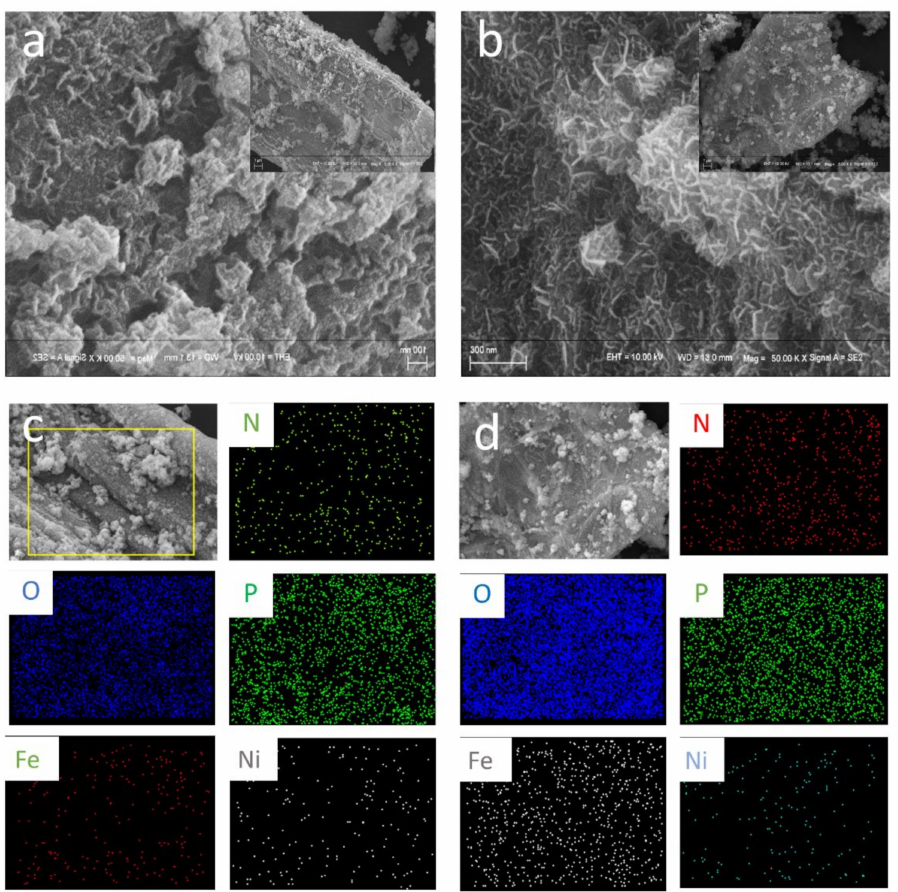
Figure 10. (( a , b ), inset shows low magnification) SEM images and ( c , d ) elements mapping of N-B-Ni 7 Fe 3 P/SEP-2 and N-B-Ni 7 Fe 3